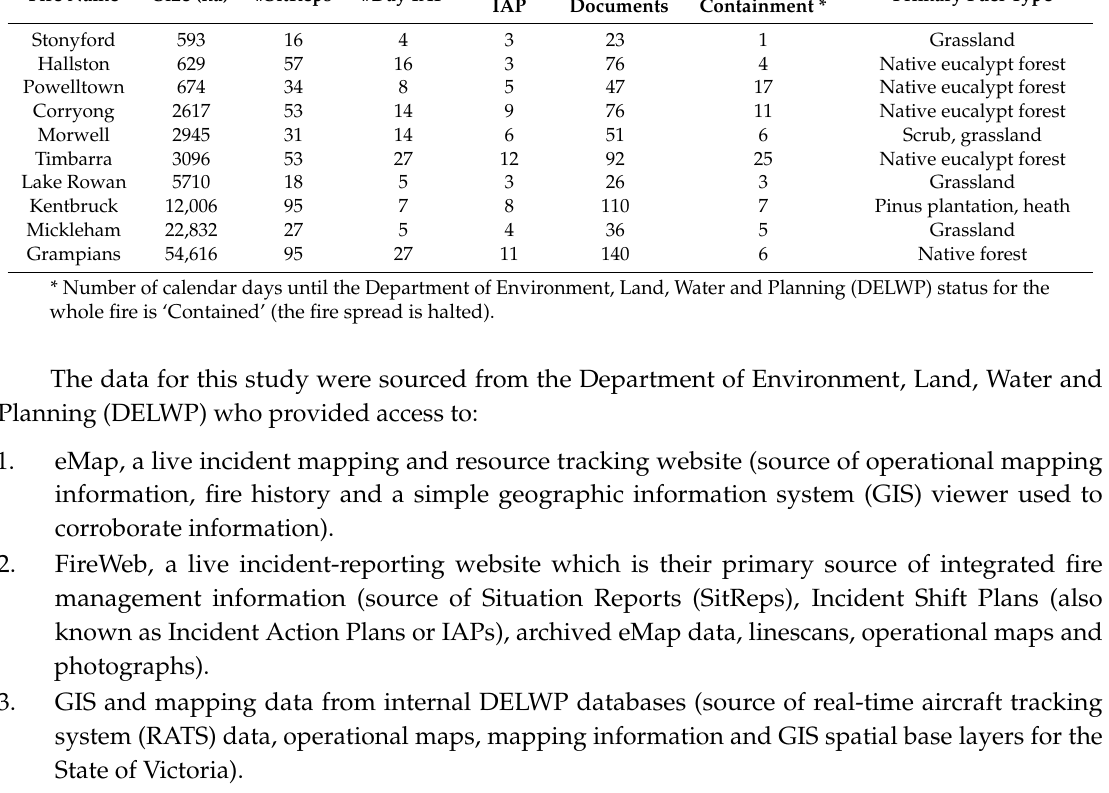
Table 2. Fire suppression. Selected wildfires: name, size and number of associated documents. Fire